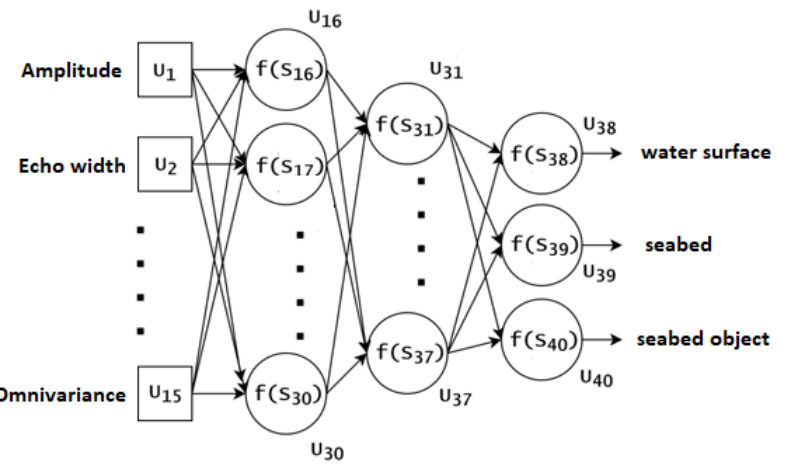
Figure 4. The architecture of ANN.